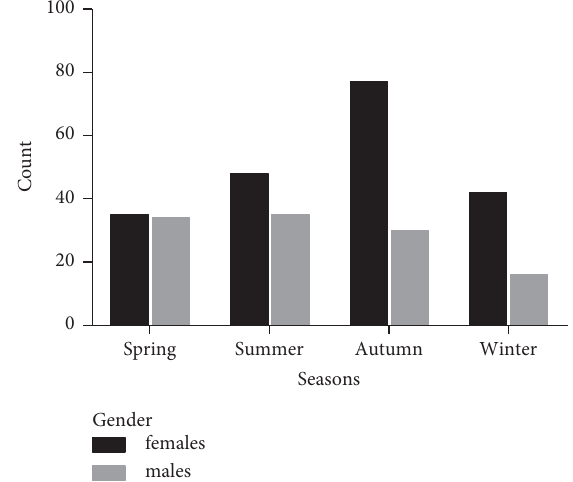
Figure 2: Te distribution of Proteus mirabilis according to season and